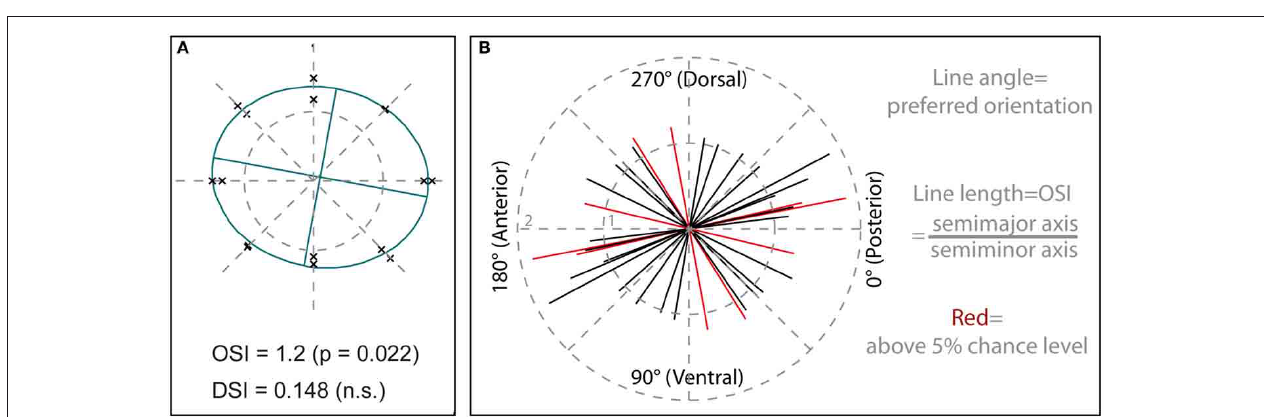
upper left corner of the image). Motion direction is depicted by the direction of the arrow. Fluorescence signals were time-averaged over the entire period of motion stimulation. Stimuli were presented on a 60Hz TFT screen.